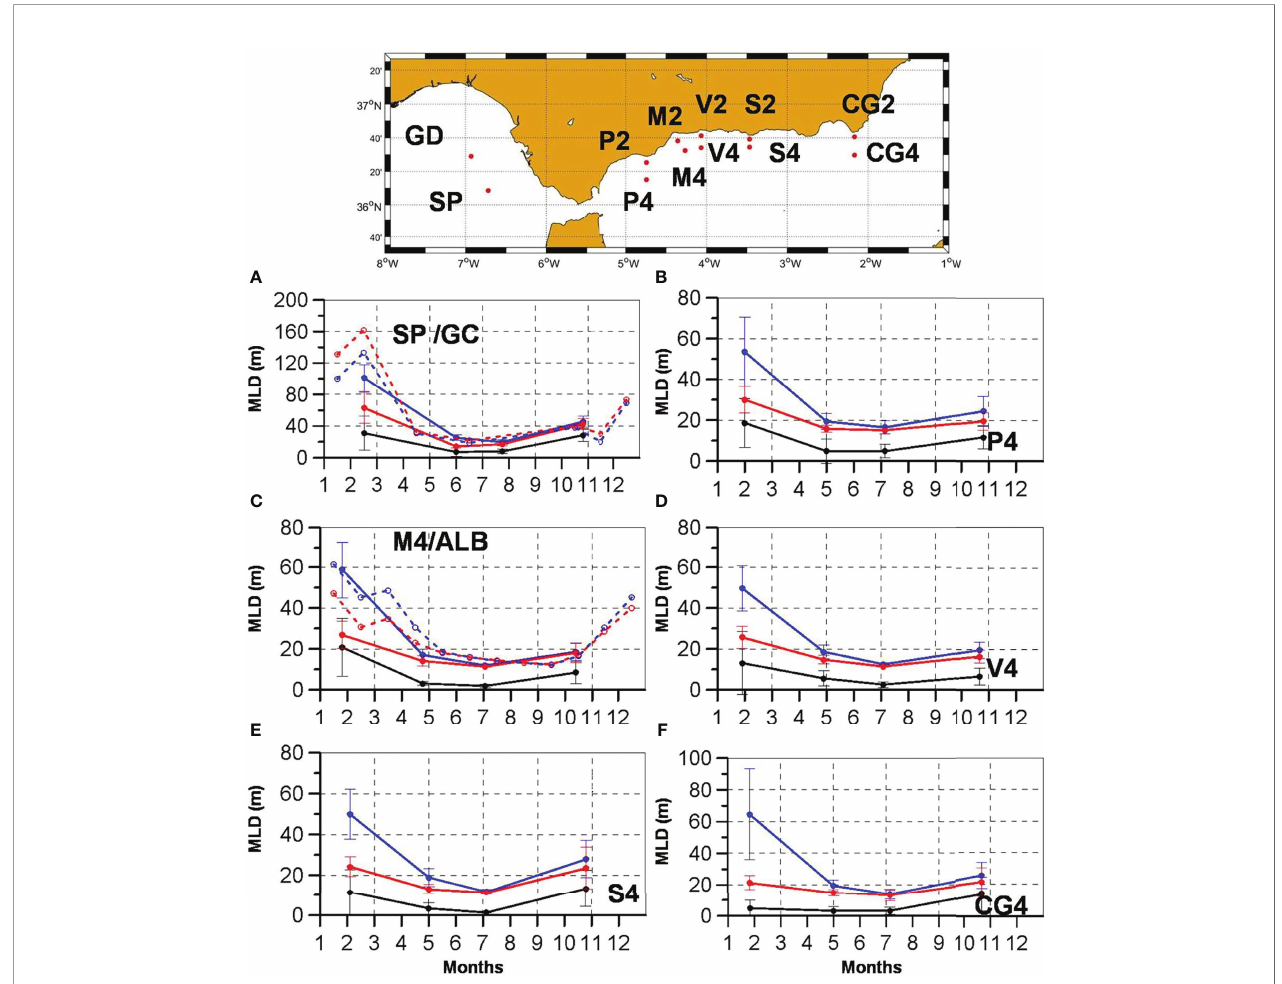
FIGURE 4 | Seasonal cycles of the MLD estimated from the three-monthly sampling of STOCA and RADMED projects (continuous lines) at some selected oceanographic stations (see labels inserted in these fi gures and the map for the locations), and form the Argo MLD at the regions of the Gulf of Ca ́ diz (A) and the Albora ́ n Sea (C) (dashed lines). Blue lines correspond to the t-threshold method, red lines to the d-threshold method, and black lines to the temperature extreme curvature method. Please, note the different ranges of the y-axis between